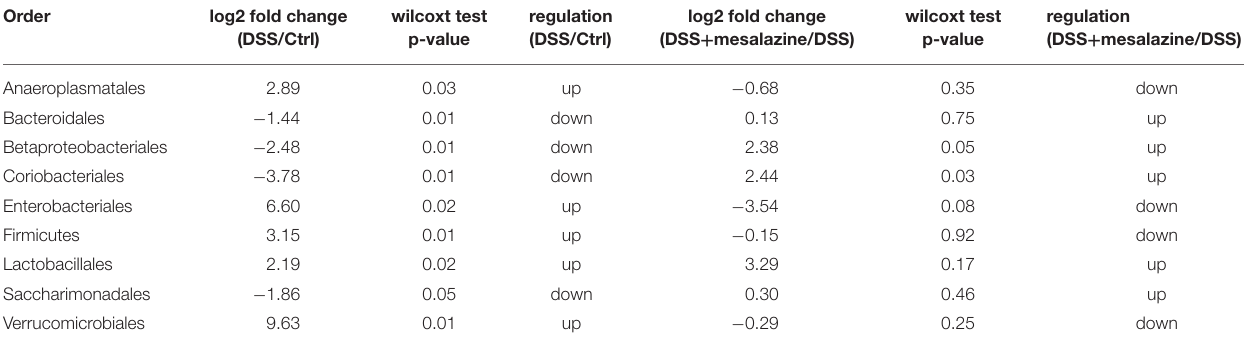
TABLE 2 | MZ treatment reversed the DSS-altered gut bacterial taxonomic composition at genus level. Genus log2 fold change